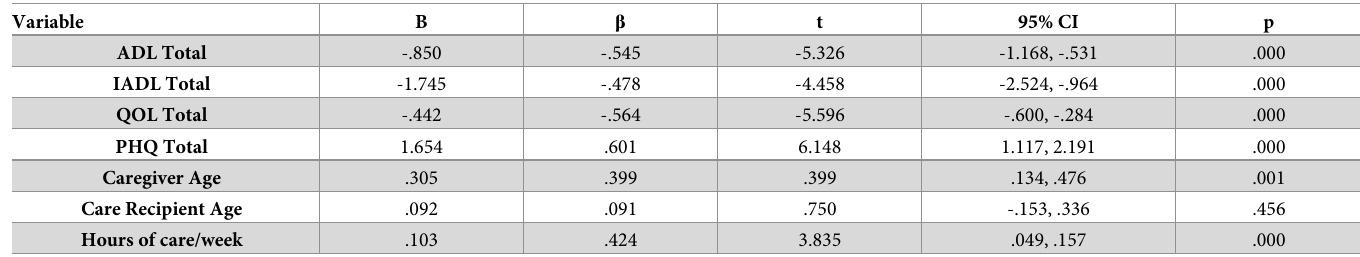
Table 4. Predictors of caregiver burden results of simple linear regression analysis. Variable B β ADL Total